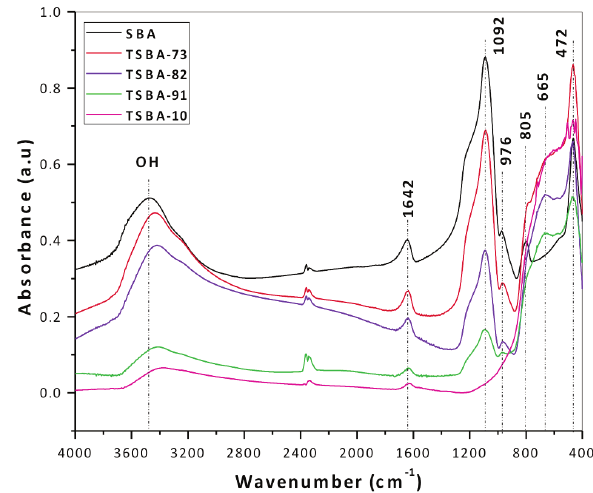
Fig. 4 - FTIR spectra of pure mesoporous silica and of the TiO 2 /SiO 2 binary